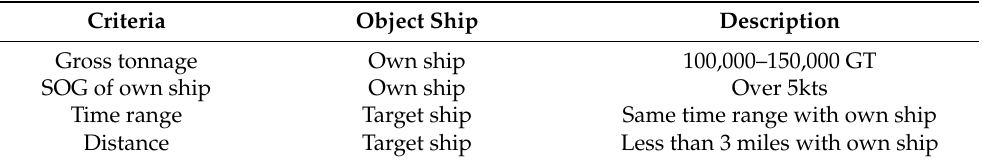
Table 2. Criteria